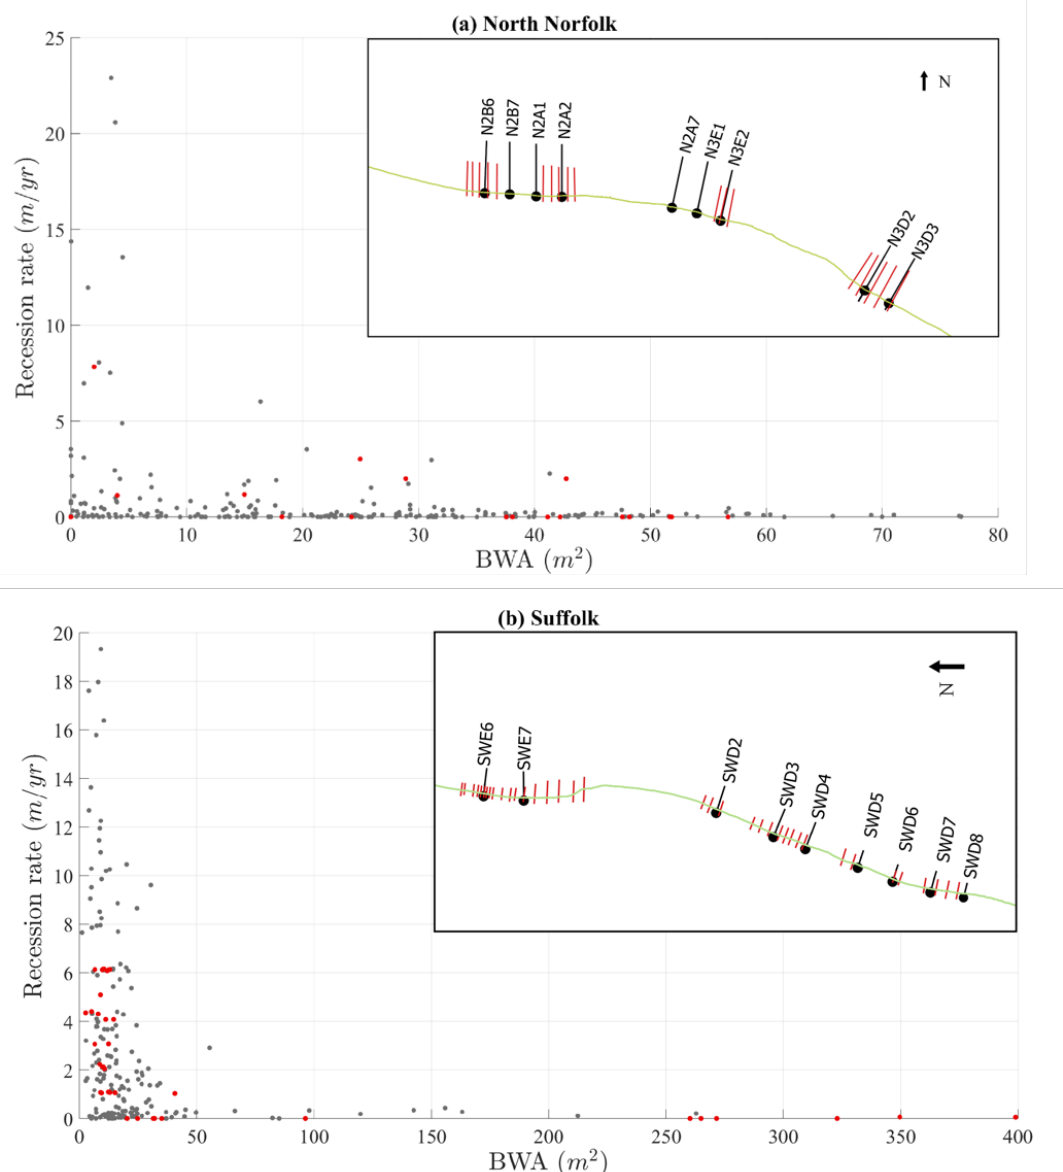
Figure 9. Cliff top recession rate and BWA extracted values from the new transects (red dots) compared with those obtained from the Environment Agency (EA) elevation profile database (grey dots). The location of the new transects for Norfolk and Suffolk are shown as red lines on panels ( a ) and ( b ), respectively. Note: The large differences between the maximum BWA areas for the study sites are due to the profiles at the Benacre Ness